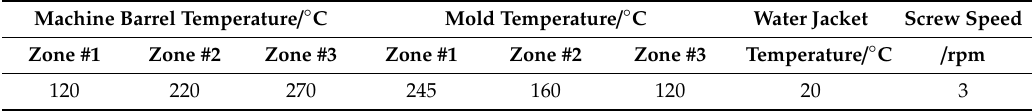
Figure 1. Flowchart of preparation of organo-montmorillonite (OMMT)-modified ultra-high- Flowchart of preparation of organo-montmorillonite (OMMT)-modified ultra-high- molecular-weight polyethylene (UHMWPE) pipe samples. molecular-weight polyethylene (UHMWPE) pipe samples. Table 1. Process parameters of screw extrusion Table 1. Process parameters of screw extrusion molding.